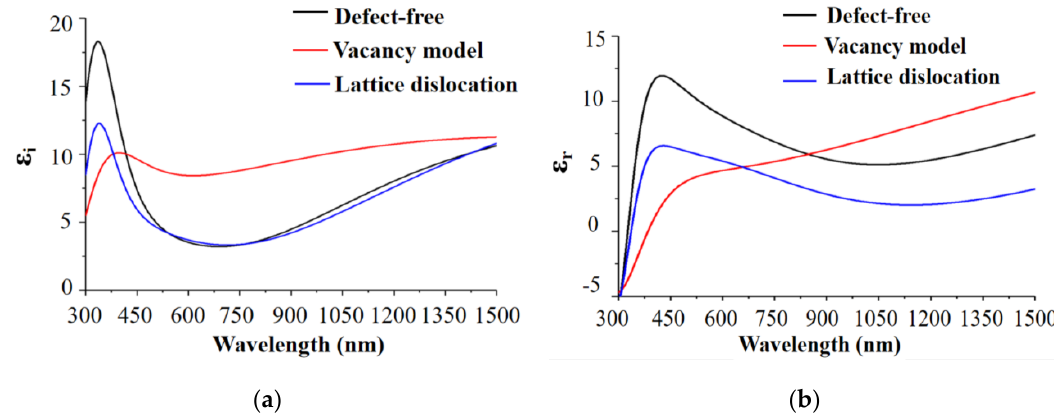
Figure 3. ( a ) Imaginary and ( b ) real parts of the dielectric functions in the di ff erent defect models at 300–1500 nm.